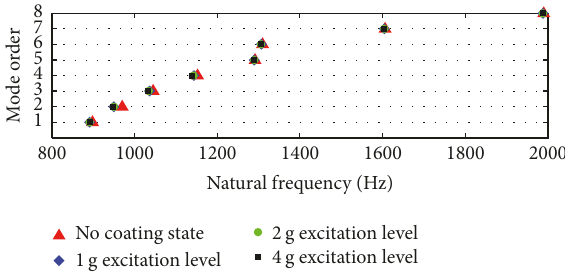
Figure 9: The scattergrams of natural frequencies of cantilever cylindrical shell coated with and without hard coating under different excitation levels.